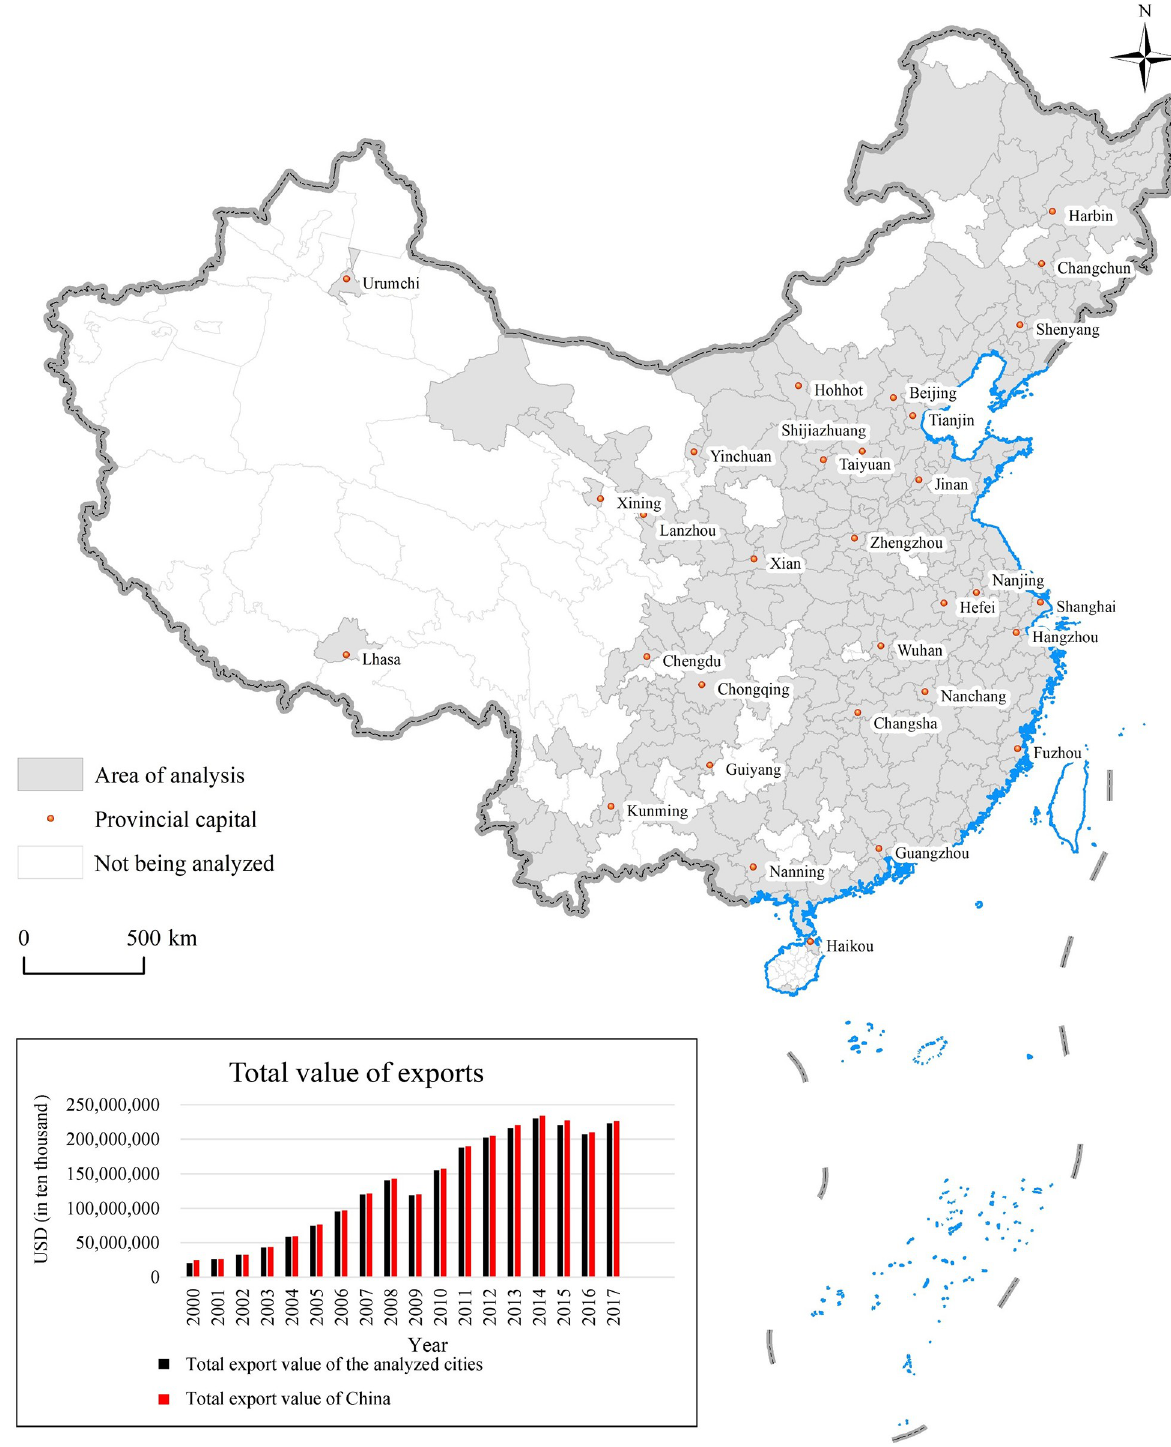
Fig 2. Study area.